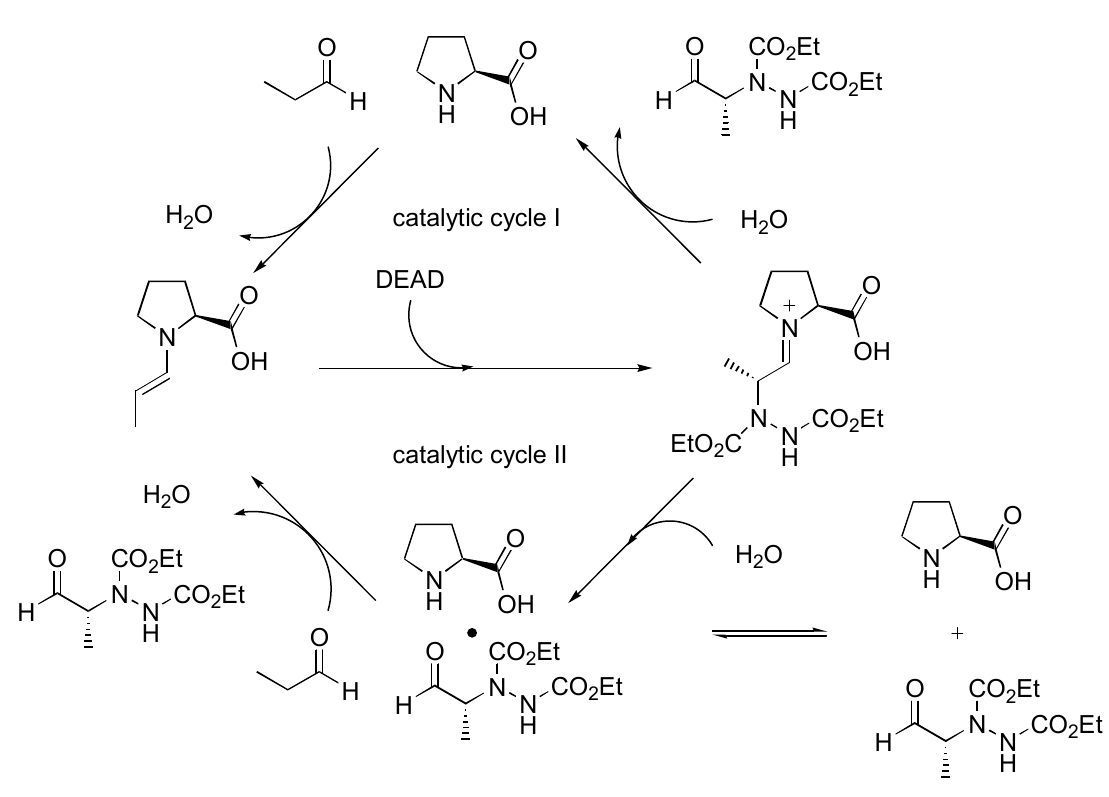
Figure 6. Catalytic cycles of proline-catalyzed amination of aldehydes as proposed by Blackmond et al.